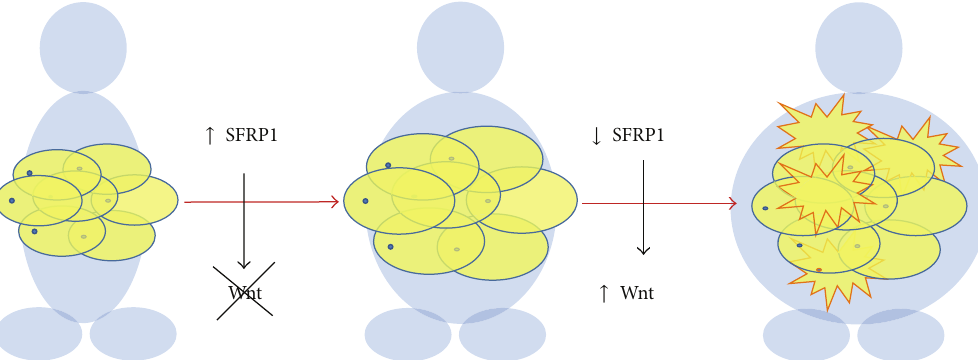
Figure 3: Secreted frizzled-related protein 1 (SFRP1) upregulation in early stages of obesity facilitates adipose tissue expansion, falling in morbidly obese patients